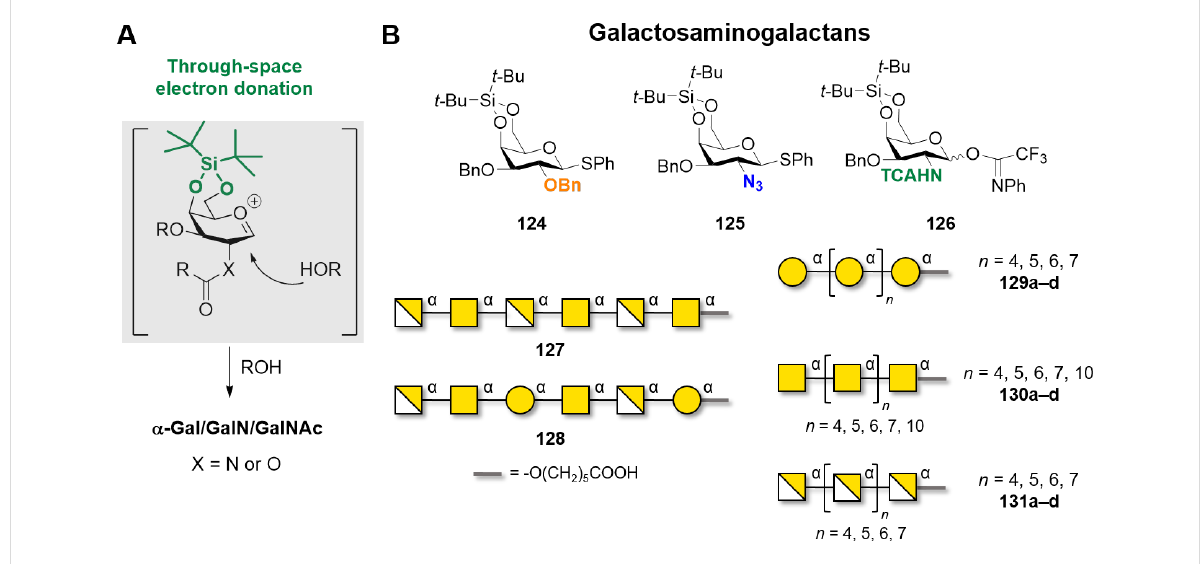
Figure 11: A) The DTBS PG stabilizes the 3 H 4 conformation of the Gal oxocarbenium ion favoring the attack of the alcohol from the α -face in a S N 1 manner. B) Key BBs used in the synthesis of galactosaminogalactans bearing the α -directing DTBS PG.